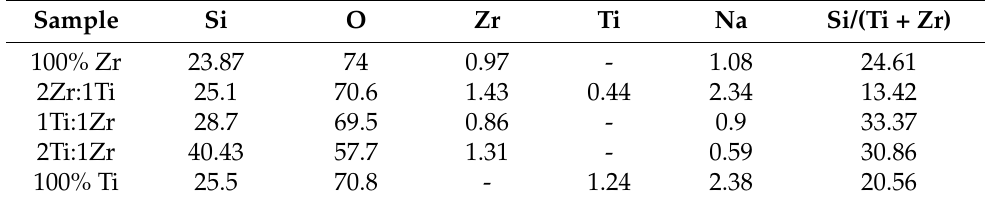
Table 2. Results of EDX analysis of orthorhombic shapes.